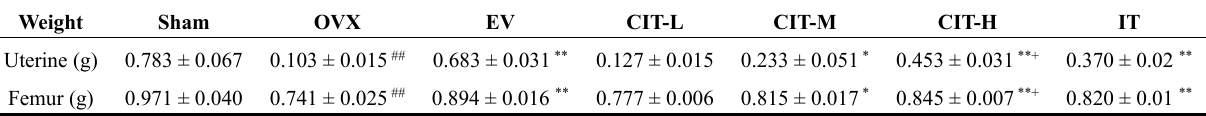
Table 1. The comparation of femur weight and uterine wet weight.